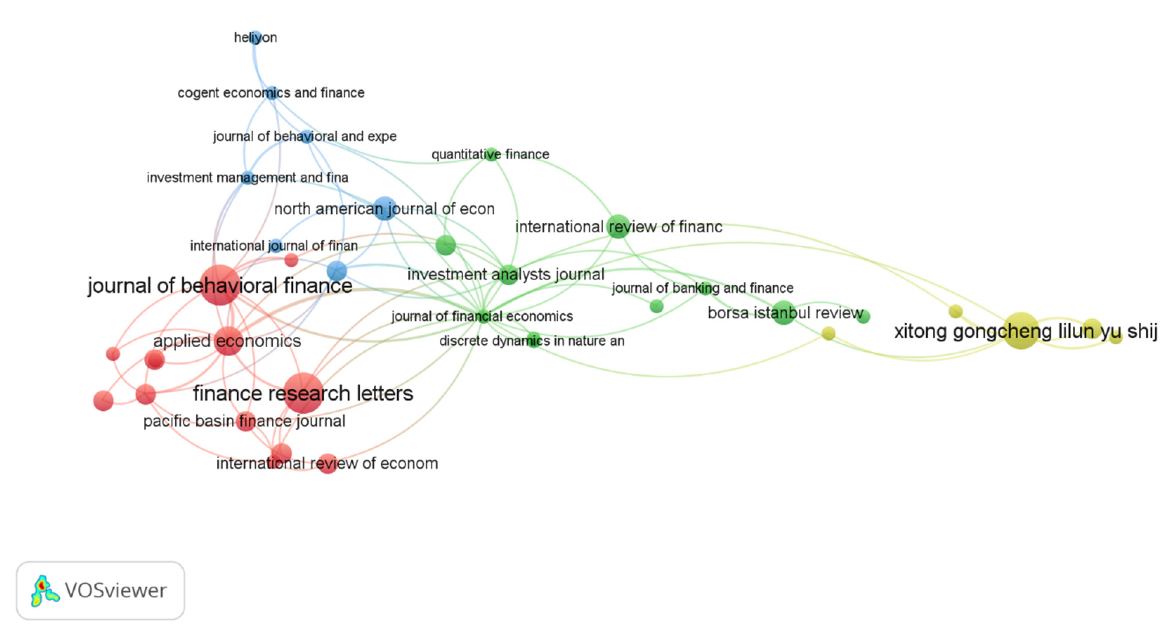
Figure 7. Bibliographic coupling.